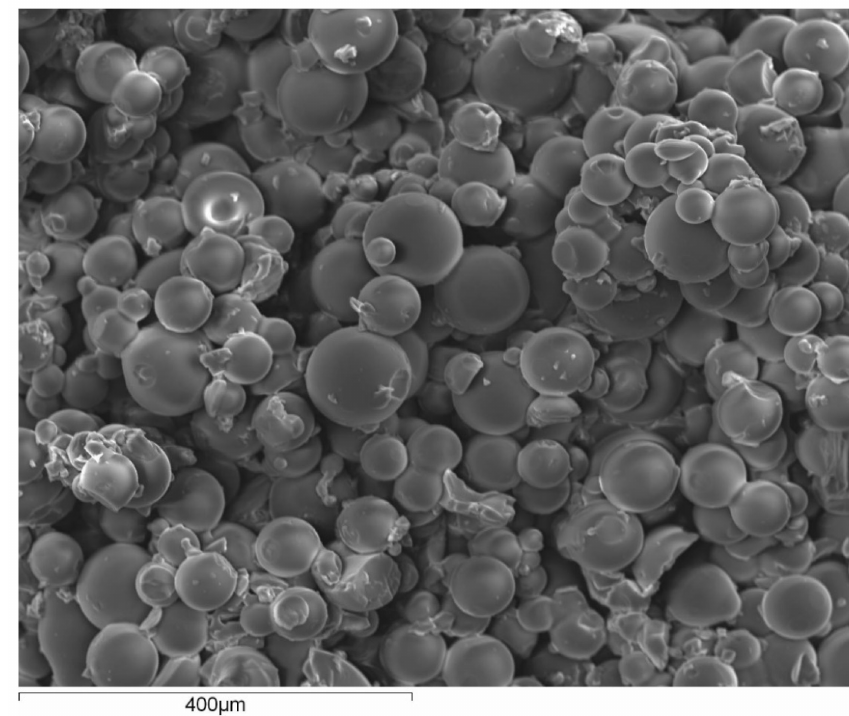
Figure A2. SEM image of PEGMA-Cl (magnification ×